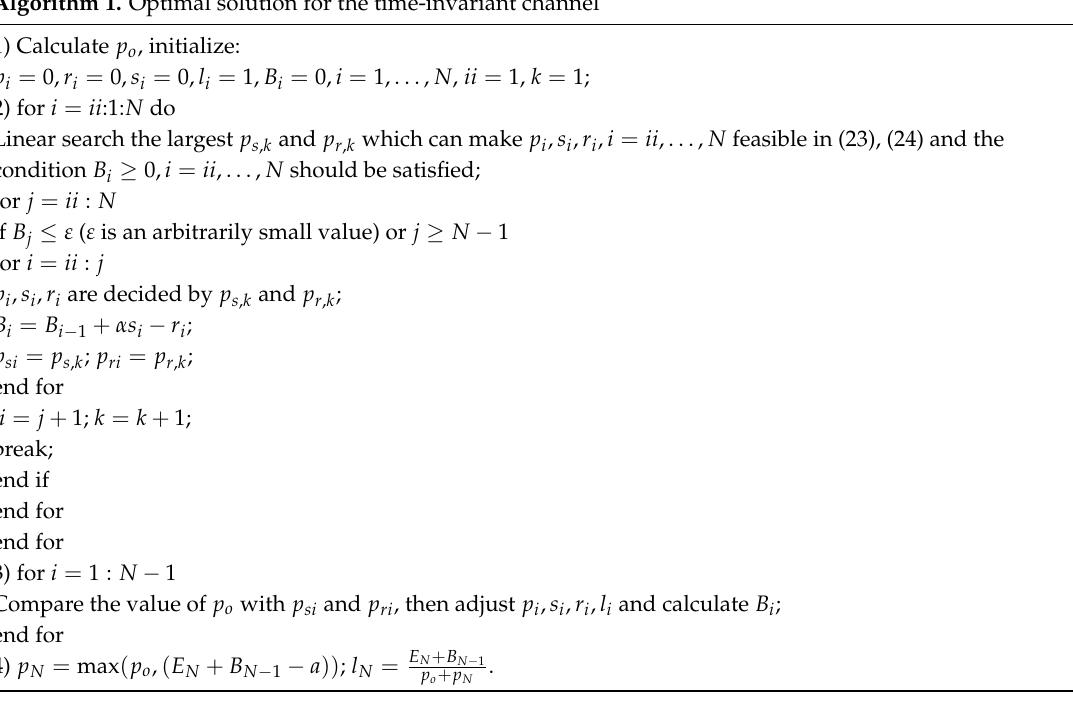
Algorithm 1. Optimal solution for the time-invariant